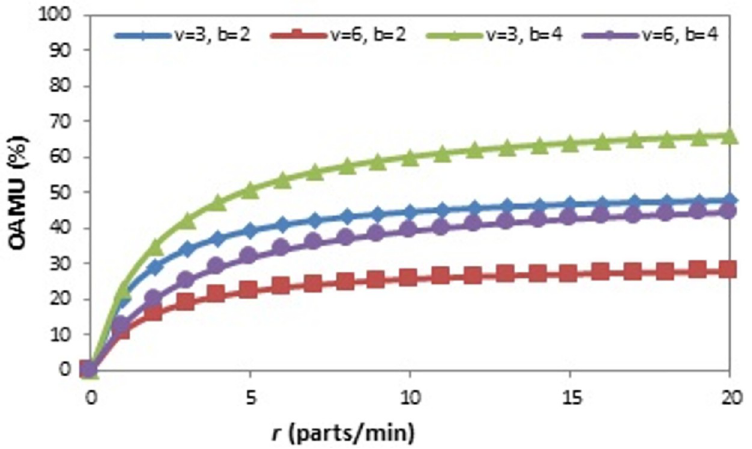
Fig 6. OAMU-r diagram for single-machine